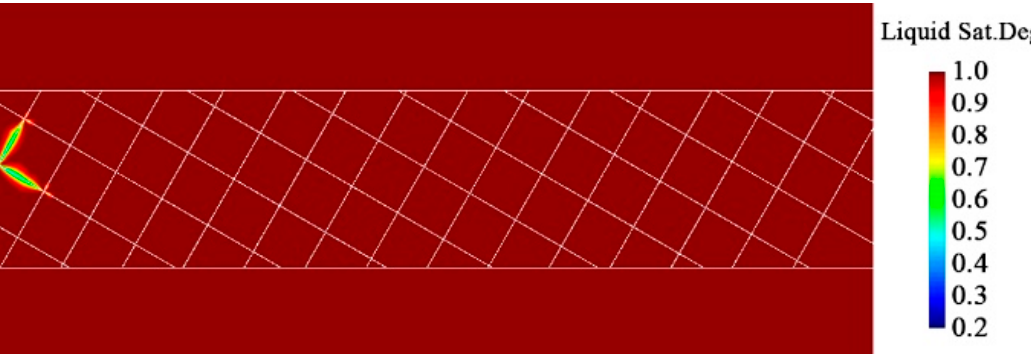
Figure 4. Distribution of liquid saturation degree for low-temperature CO 2 injection after 365 days of injection and production for fractures with intrinsic permeability of 10 − 14 m 2 .